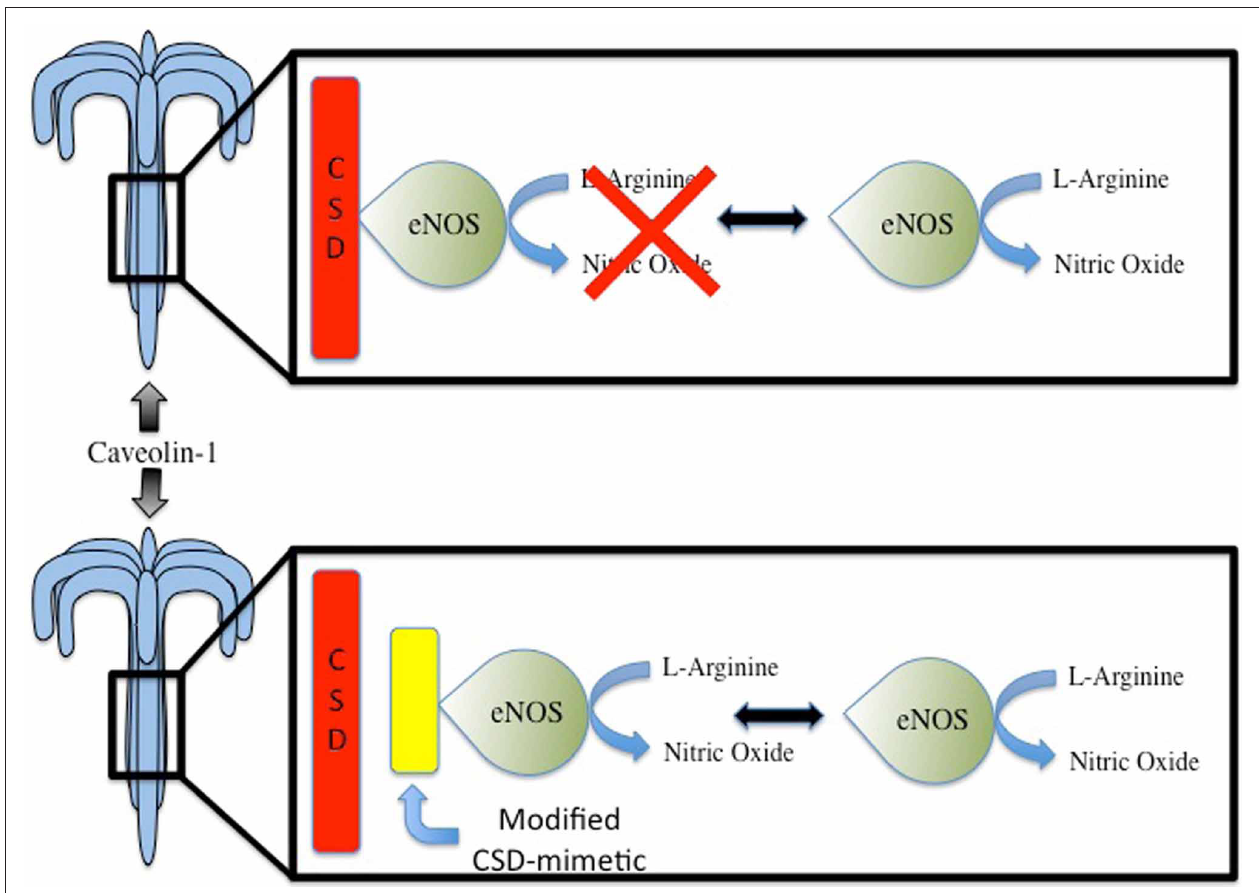
FIGURE 1 | Under basal conditions, endothelial nitric oxide synthase (eNOS) is the main producer of nitric oxide (NO) in the cardiovascular system. Interaction between eNOS and Caveolin Scaffolding Domain (CSD) of Caveolin-1 leads to inhibition of eNOS activity. Compounds that can mimic